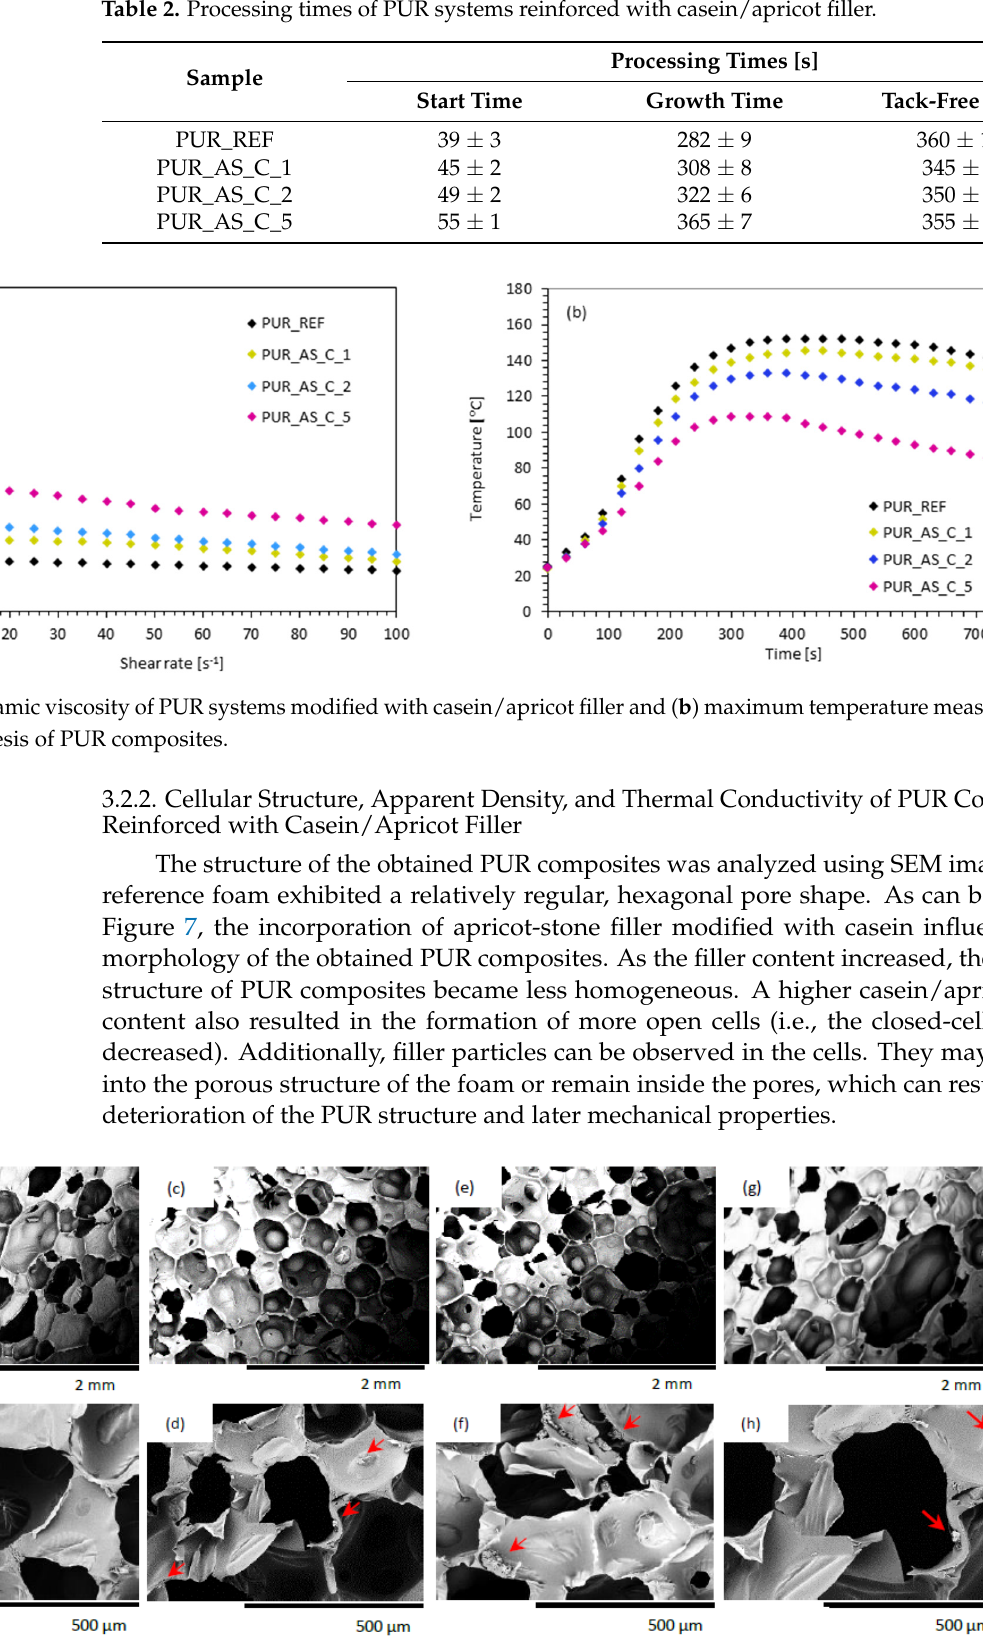
Figure 7. Cellular morphology of PUR composites: ( a , b ) PUR_REF; ( c , d ) PUR_AS_C_1; ( e , f ) PUR_AS_C_2; ( g , h ) PUR_AS_C_5.